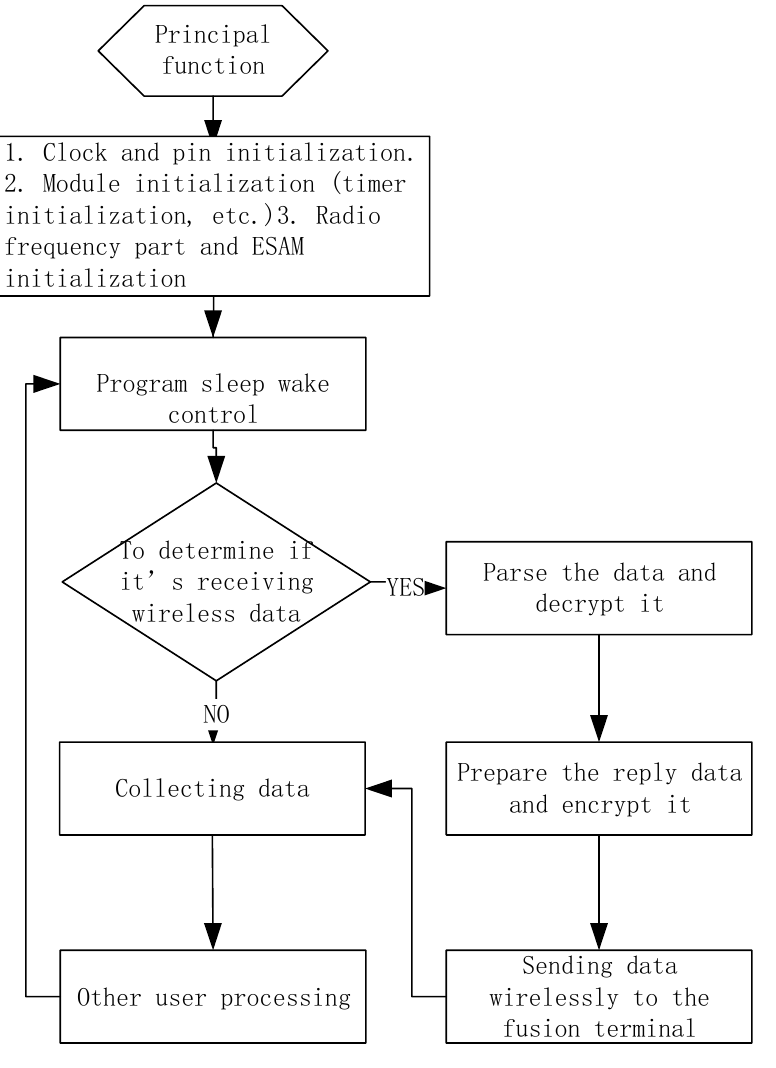
Figure 6. Software flow